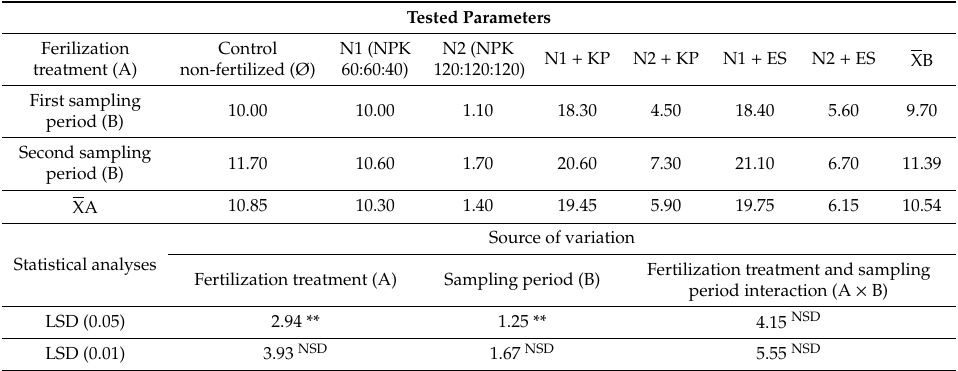
Table 4. E ff ect of the fertilization treatment (A), sampling period (B), and fertilization treatment and